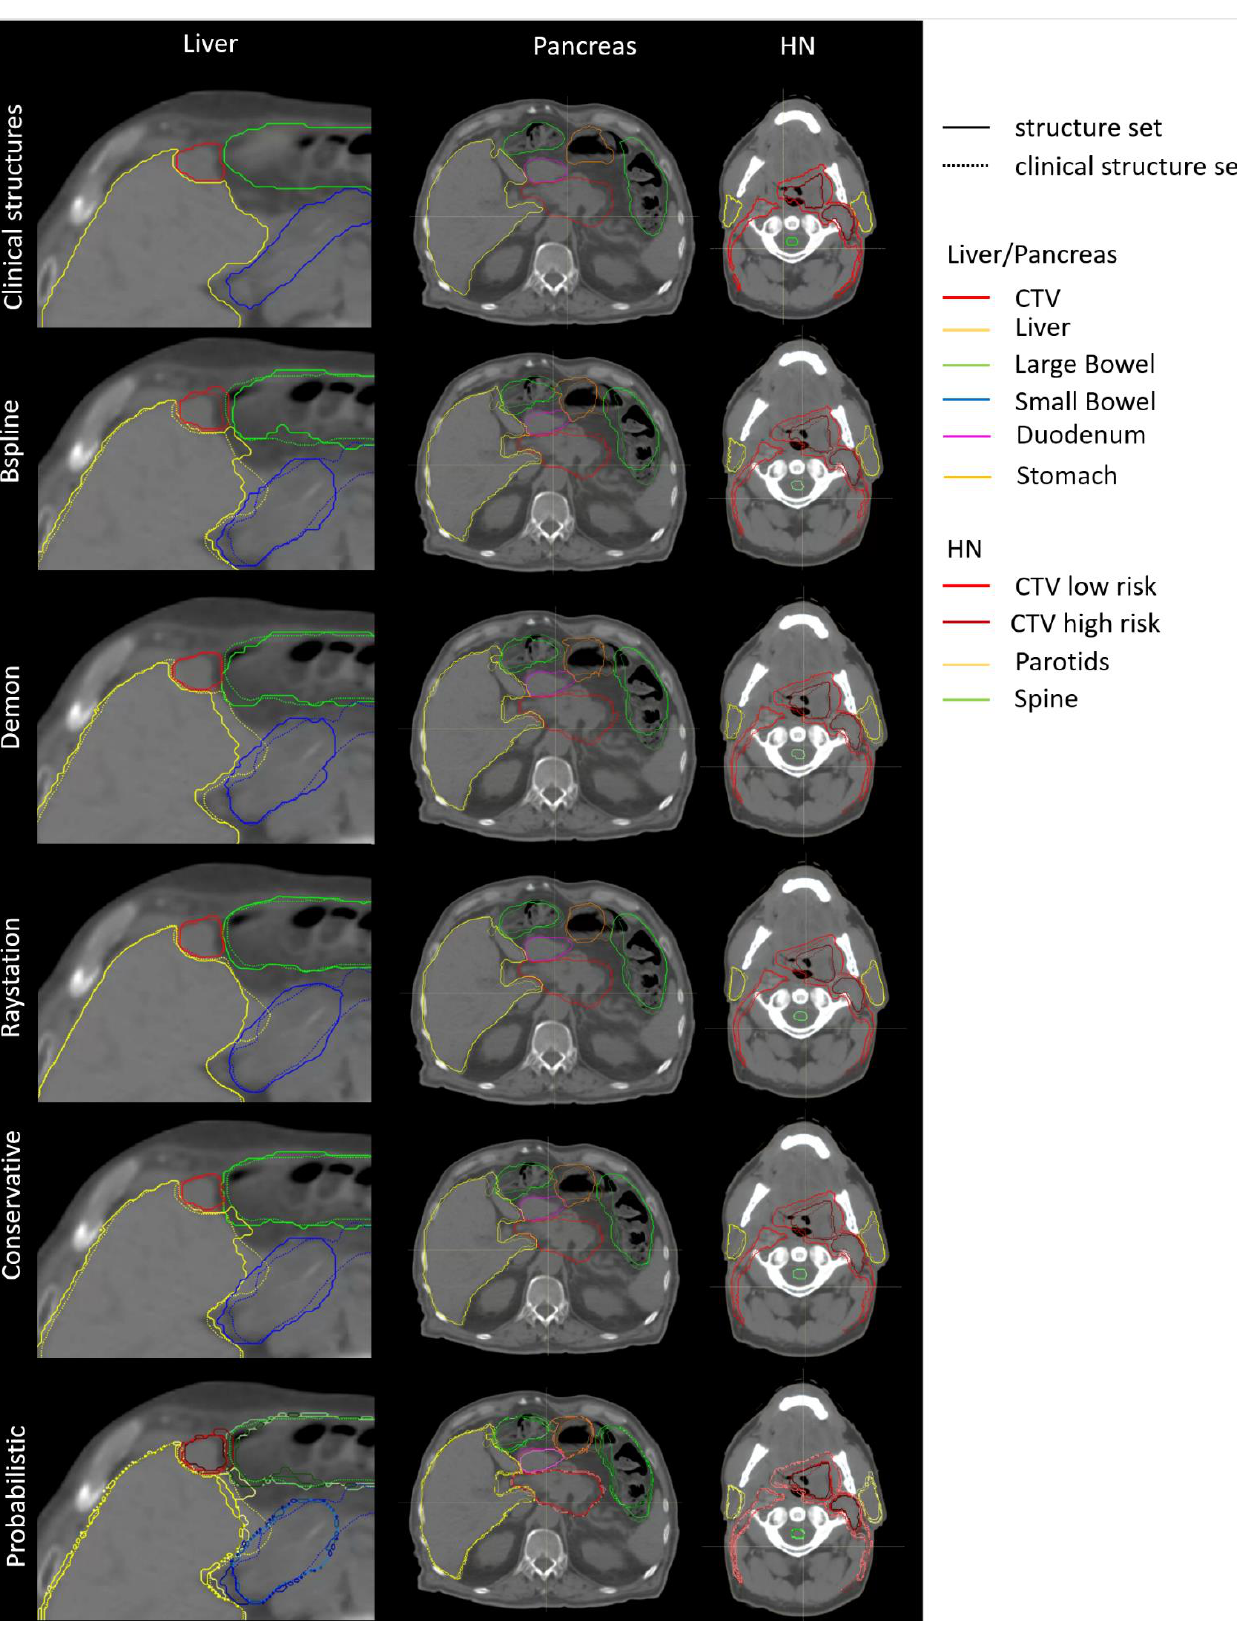
Figure 3. Example of the clinical, deformed, conservative, and probabilistic structures set for each indication. The clinical reference is overlayed in dashed lines with the propagated